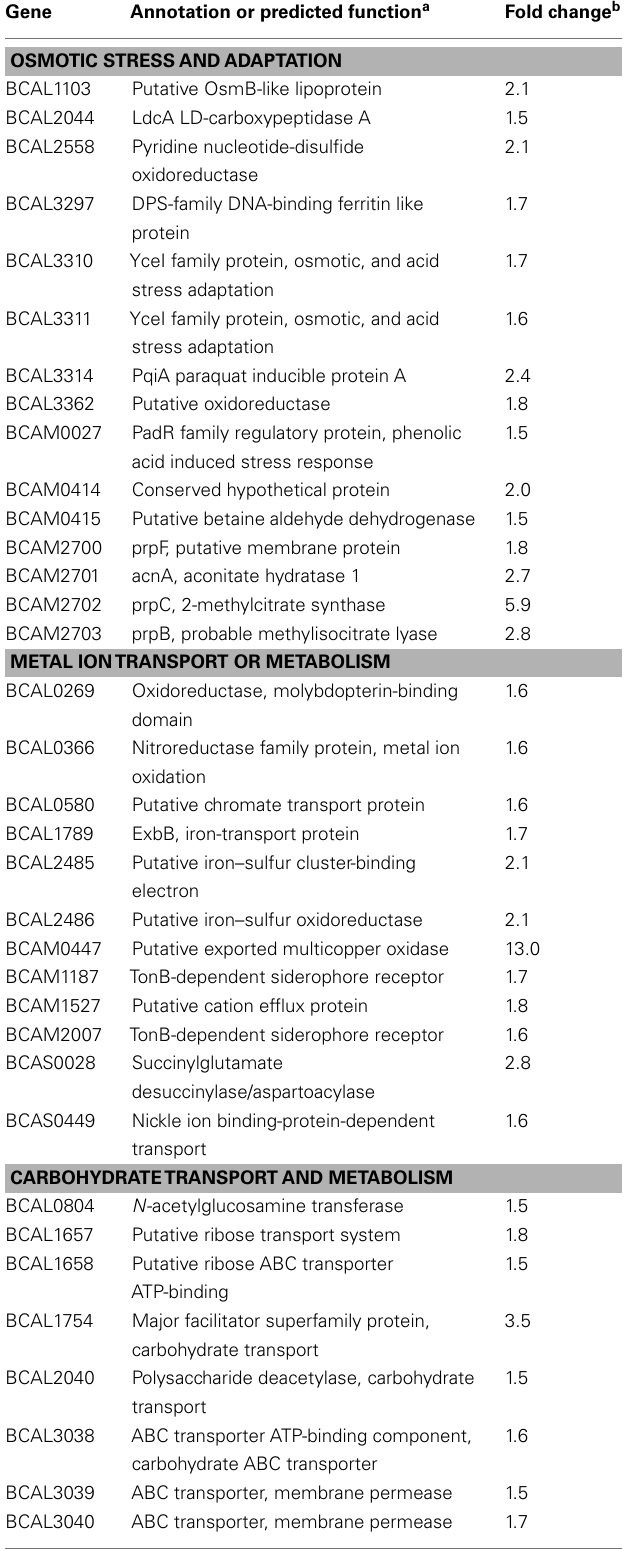
Table 4 | Selected genes induced during chronic lung